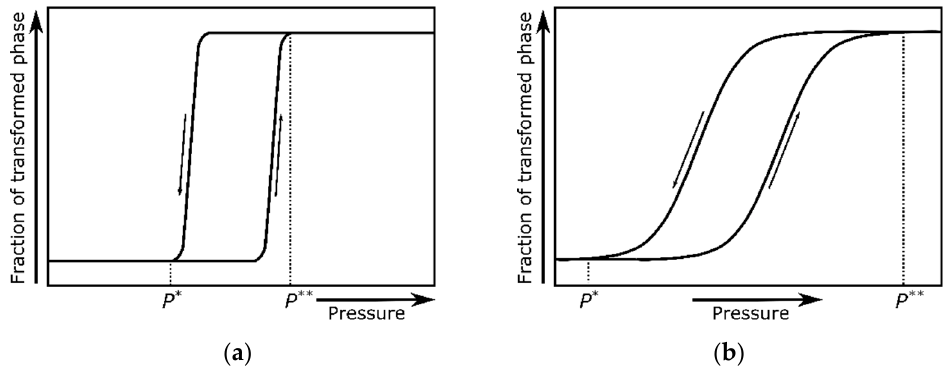
Figure 2. The fraction of the transformed phase as a function of pressure representing a relatively fast ( a ) and slow ( b ) rate of interconversion. P * and P ** mark the lower and upper bounds of the phase coexistence range.